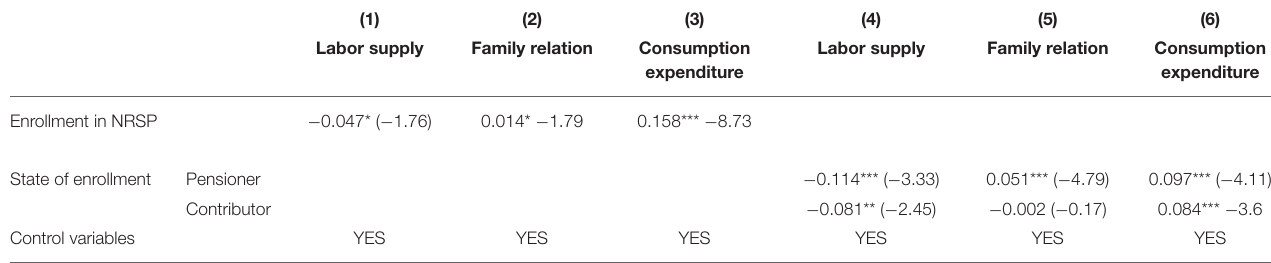
TABLE 8 | Identification of mediation variables.